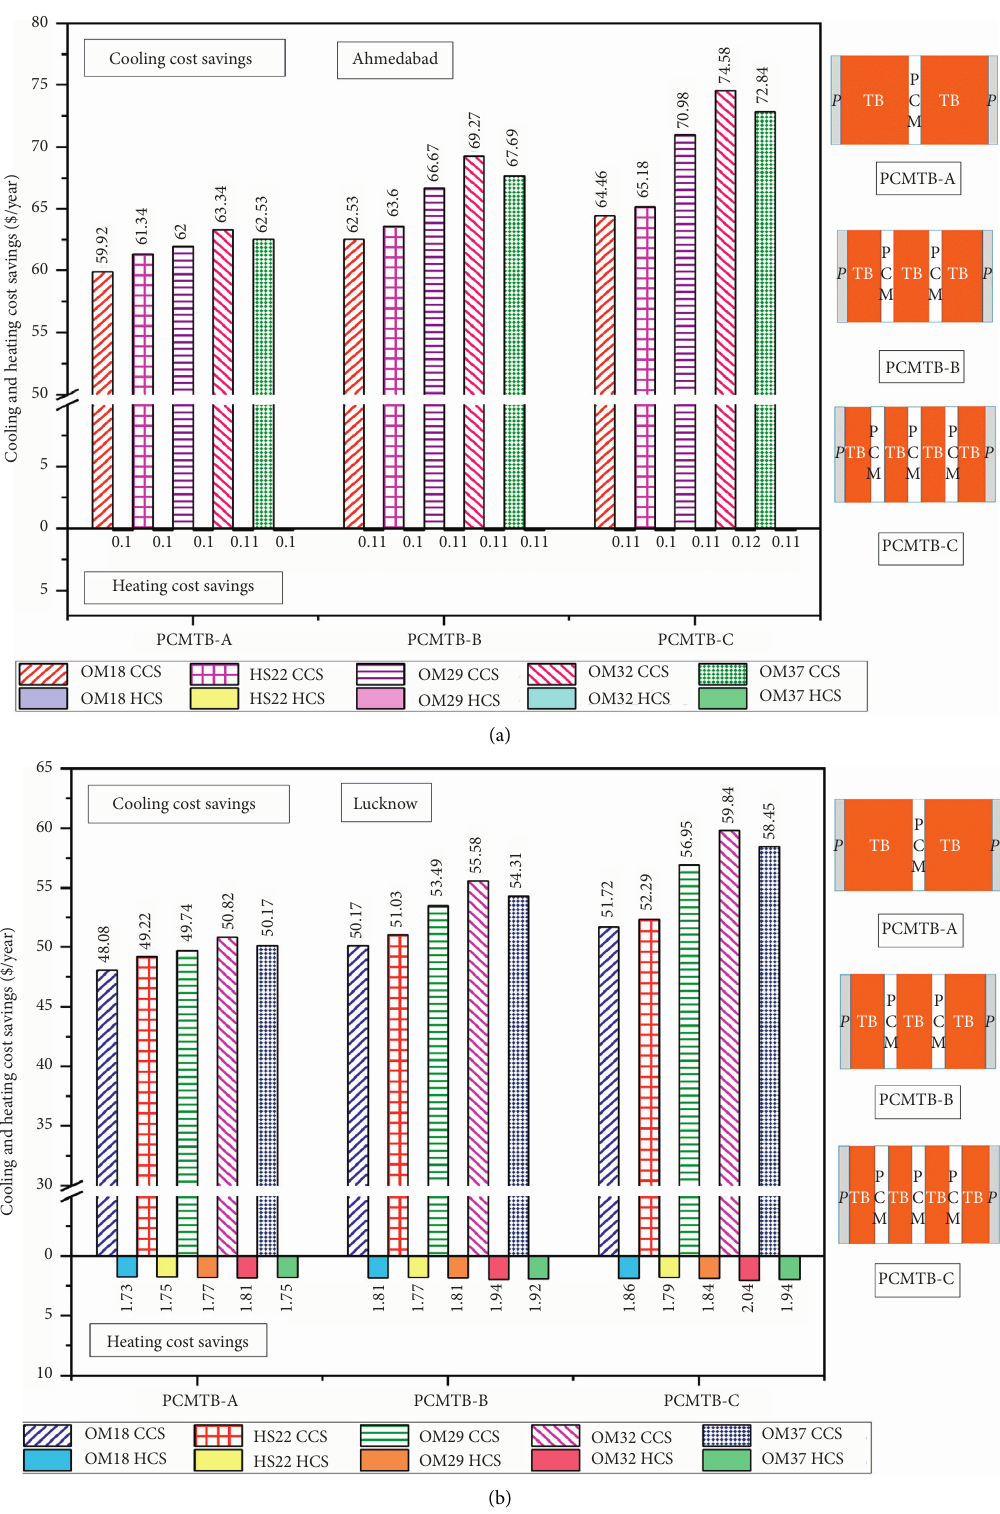
Figure 6: Annual cooling and heating cost of terracotta brick buildings integrated with PCMs: (a) Ahmedabad; (b)